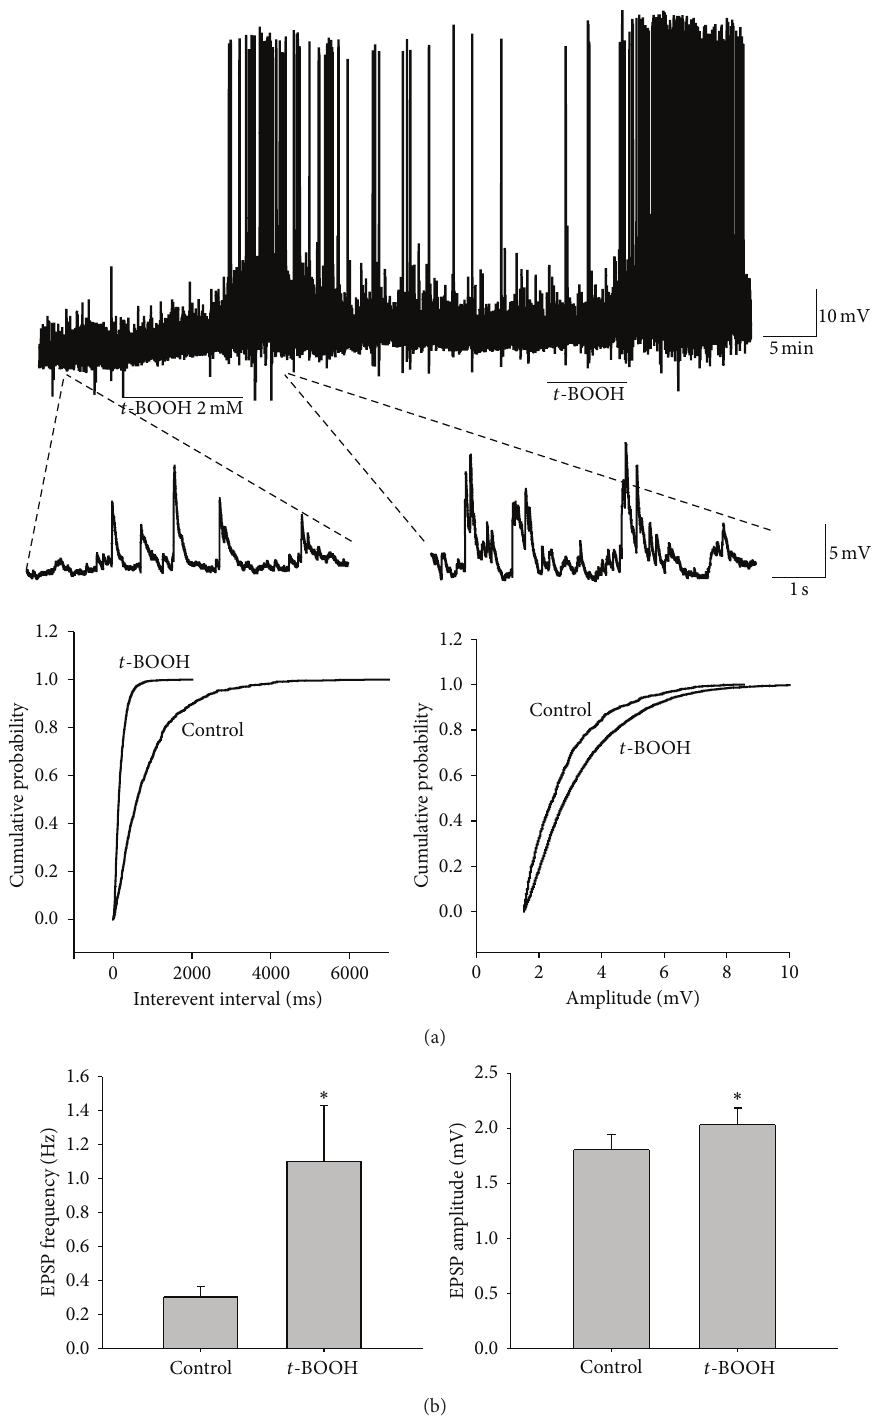
Figure 3: Effects of t -BOOH on membrane potential and EPSP in a patch clamp recording of SG neurons. (a) Original amplitude traces of EPSP in an SG neuron show that t -BOOH (2mM, 7 min) increased the amplitude and frequency of EPSPs. The lower traces show EPSP at an expanded time scale. Normalized cumulative distribution analysis of EPSP amplitude and frequency (lower panels) showed that t -BOOH caused a significant shift toward higher frequency (left) and amplitude (right) in the neuron. (b) Average EPSP frequency (left) and amplitude (right). After application of t -BOOH, both the frequency and the amplitude increased significantly ( 𝑃 < 0.05 , asterisks) from pre- t -BOOH levels as determined by a paired 𝑡 -test. The data are mean with standard errors of the